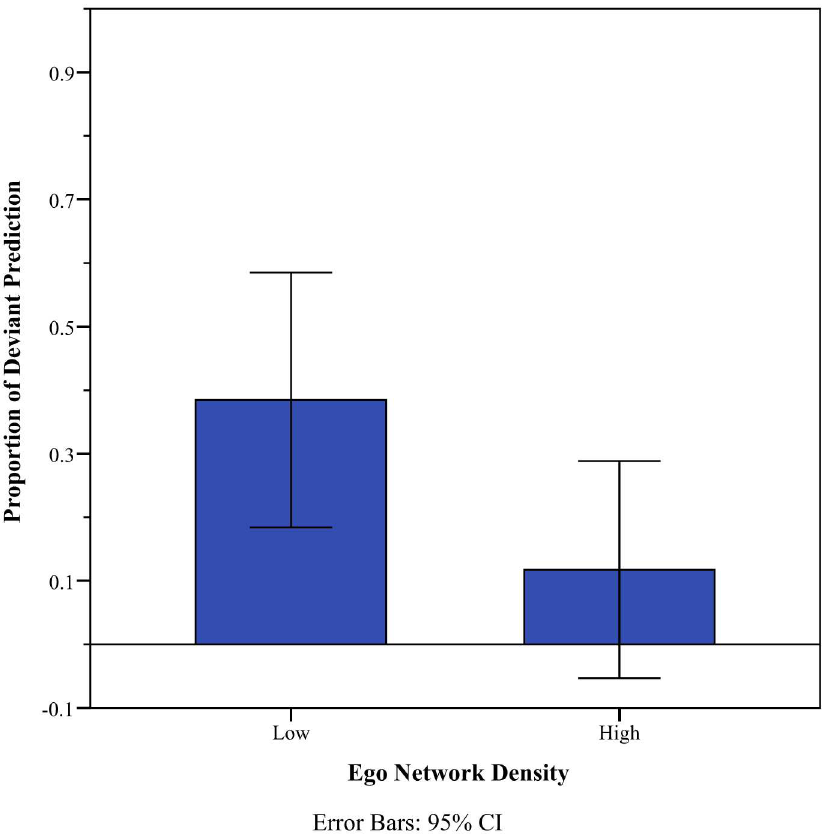
Fig 6. Network density and deviation to initial opinions. The responsevariableis the proportionof the participants whose prediction for the first game was opposite their prior beliefs. N =